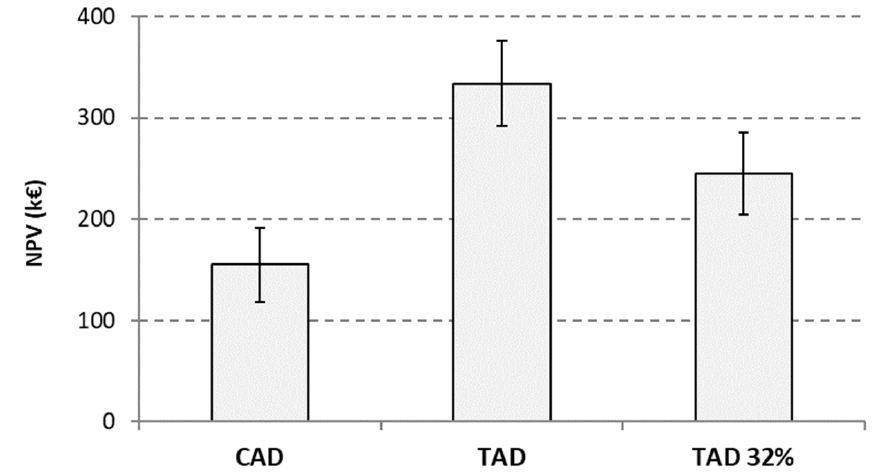
Figure 6. Sensitivity analysis: the error bars correspond to the ±10% range of CAPEX.